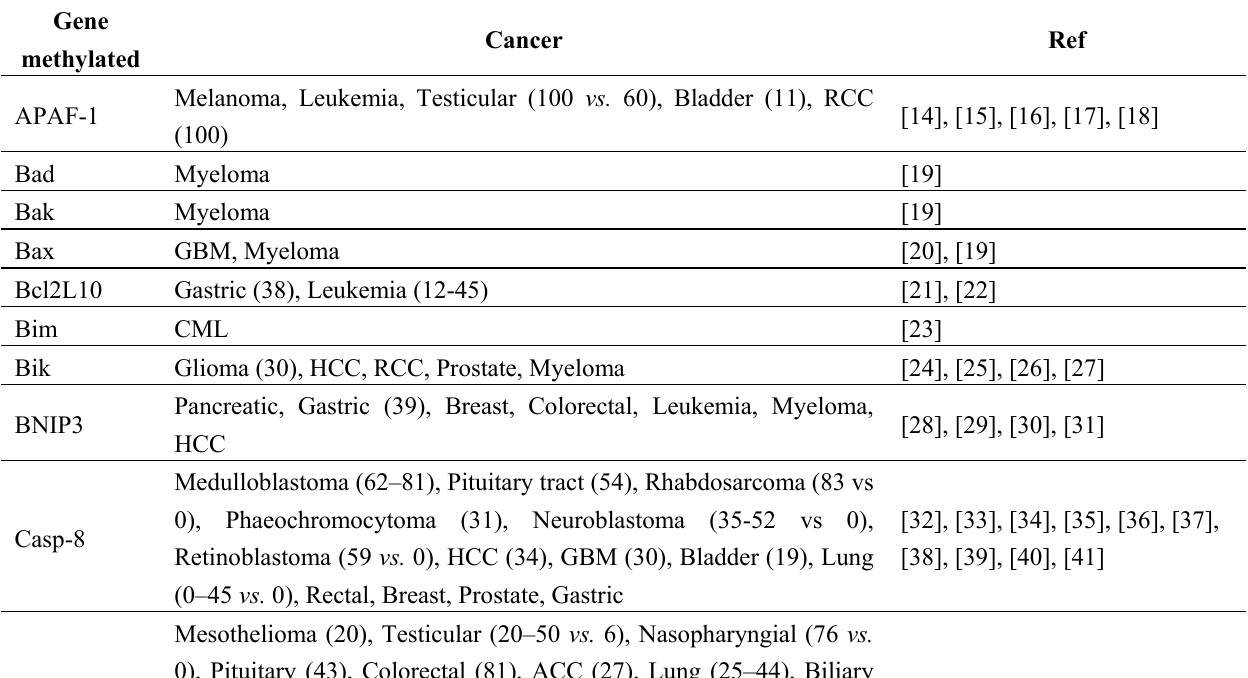
Table 1. Apoptosis related genes are frequently methylated in tumors. Percentage of methylated tumors is indicated in brackets for significant histochemical